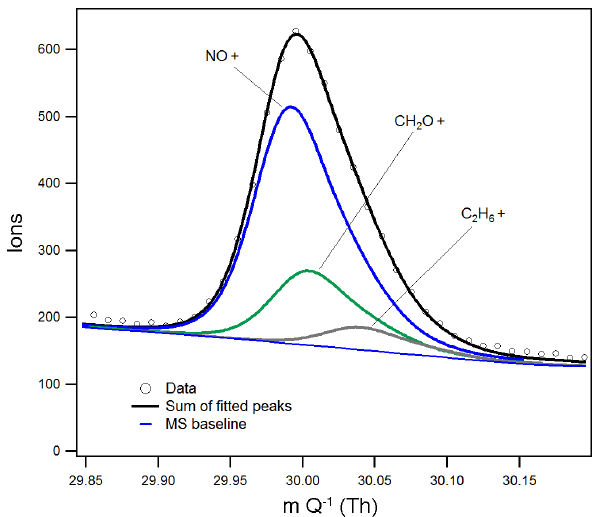
Figure 7. The isobaric peaks from NO + ( m/Q = 29.997Th) and CH 2 O + ( m/Q = 30.010Th) at 30Th have a peak separation of 0.34 half-widths for resolving power m/(cid:49)m = 400.